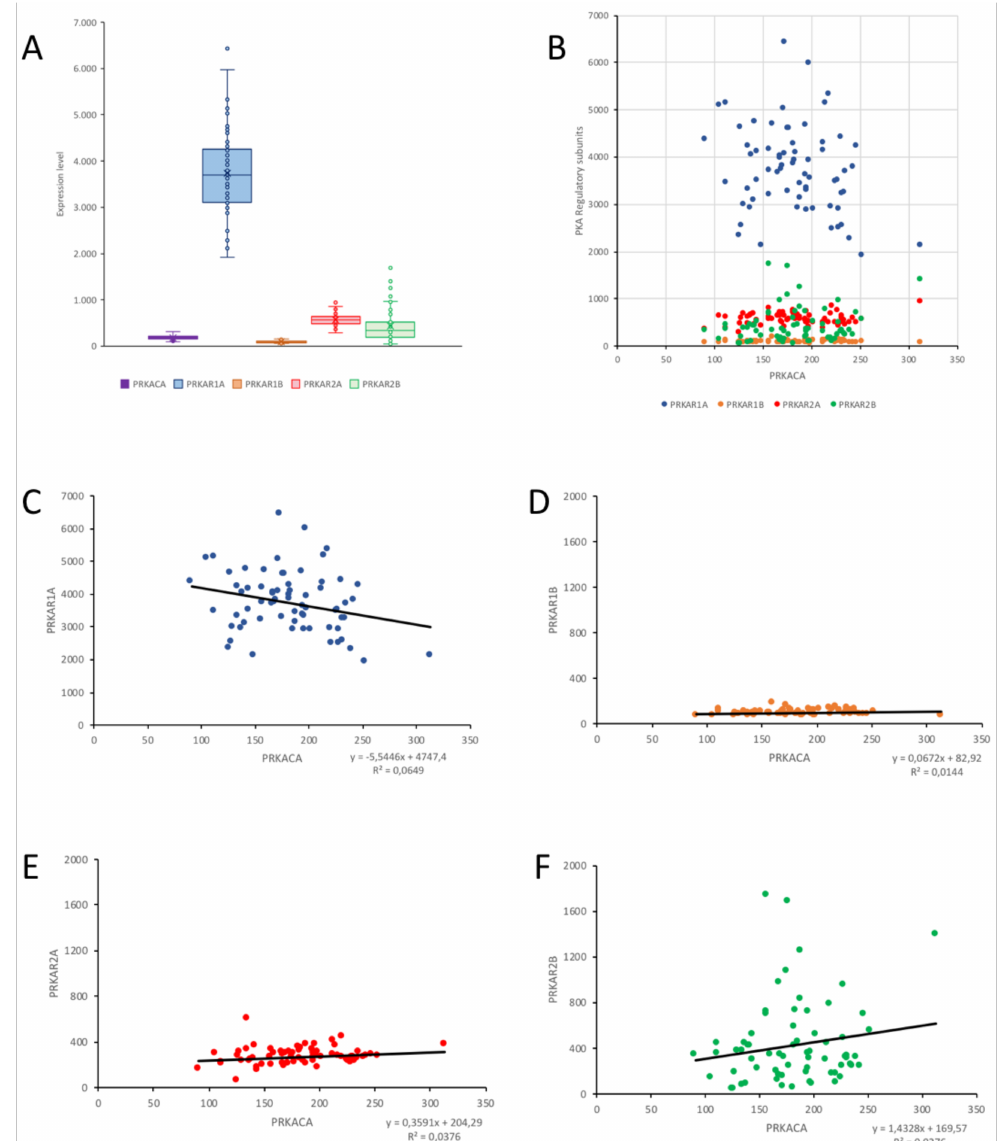
Figure 4. Gene expression of PKA catalytic and regulatory subunits in a cohort of 68 meningioma patients. ( A ) Gene expression level for PRKACA, PRKAR1A, PRKAR1B, PRKAR2A, and PRKAR2B. ( B ) Comparative view of the correlation between PRKACA expression and the four genes coding for the PKA regulatory subunits. ( C – F ) Correlation of the expression of PRKACA with each of the single genes for PKA regulatory subunits shown in ( B ). ( C ) A significant negative correlation is present between PRKACA and PRKAR1A expression, while weak, non-significant correlations are present between PRKACA and PRKAR1B ( D ), PRKAR2A ( E ), and PRKAR2B ( F ). Meningioma patients often present a loss of chromosome 22q, with inactivating neurofibromin2 (NF2, the gene coding for merlin) mutations in monosomic 22 specimens: NF2 expression level is positively and significantly correlated with PRKACA expression (R = 0.2994, p < 0.05), suggesting that both genes are downregulated in meningioma. Conversely, NF2 expression does not correlate significantly with any of the four PKA regulatory subunits expression levels (Table